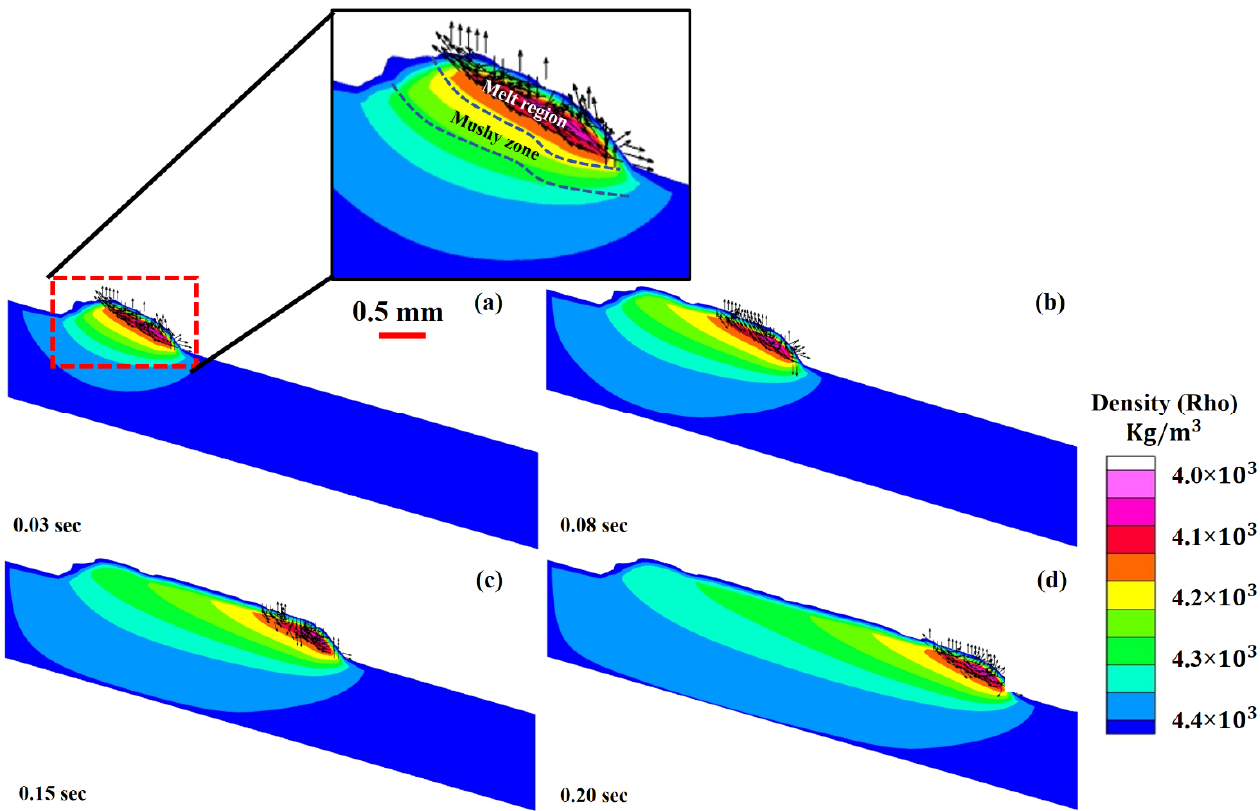
Figure 9. Deposited layer cross section having velocity vectors with liquid-solid transformation at: ( a ) 0.03 s, ( b ) 0.08 s, ( c ) 0.12 s, and ( d ) 0.15 s.